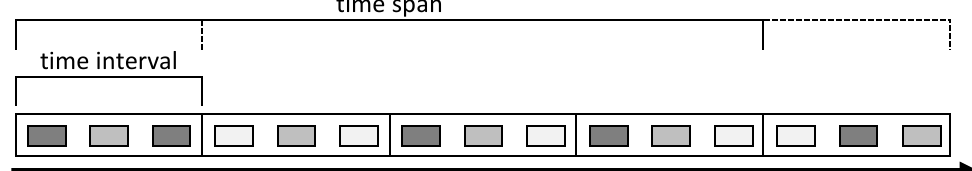
Figure 1. Representation of time span and time interval in the data